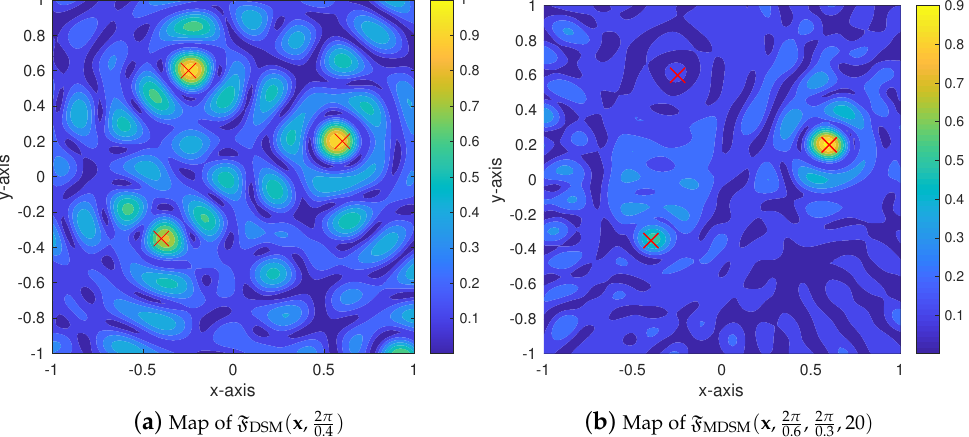
Figure 6. (Example 4) Simulation results with d = ( 0,1 ) . The red-colored marks × denote the locations of cracks.